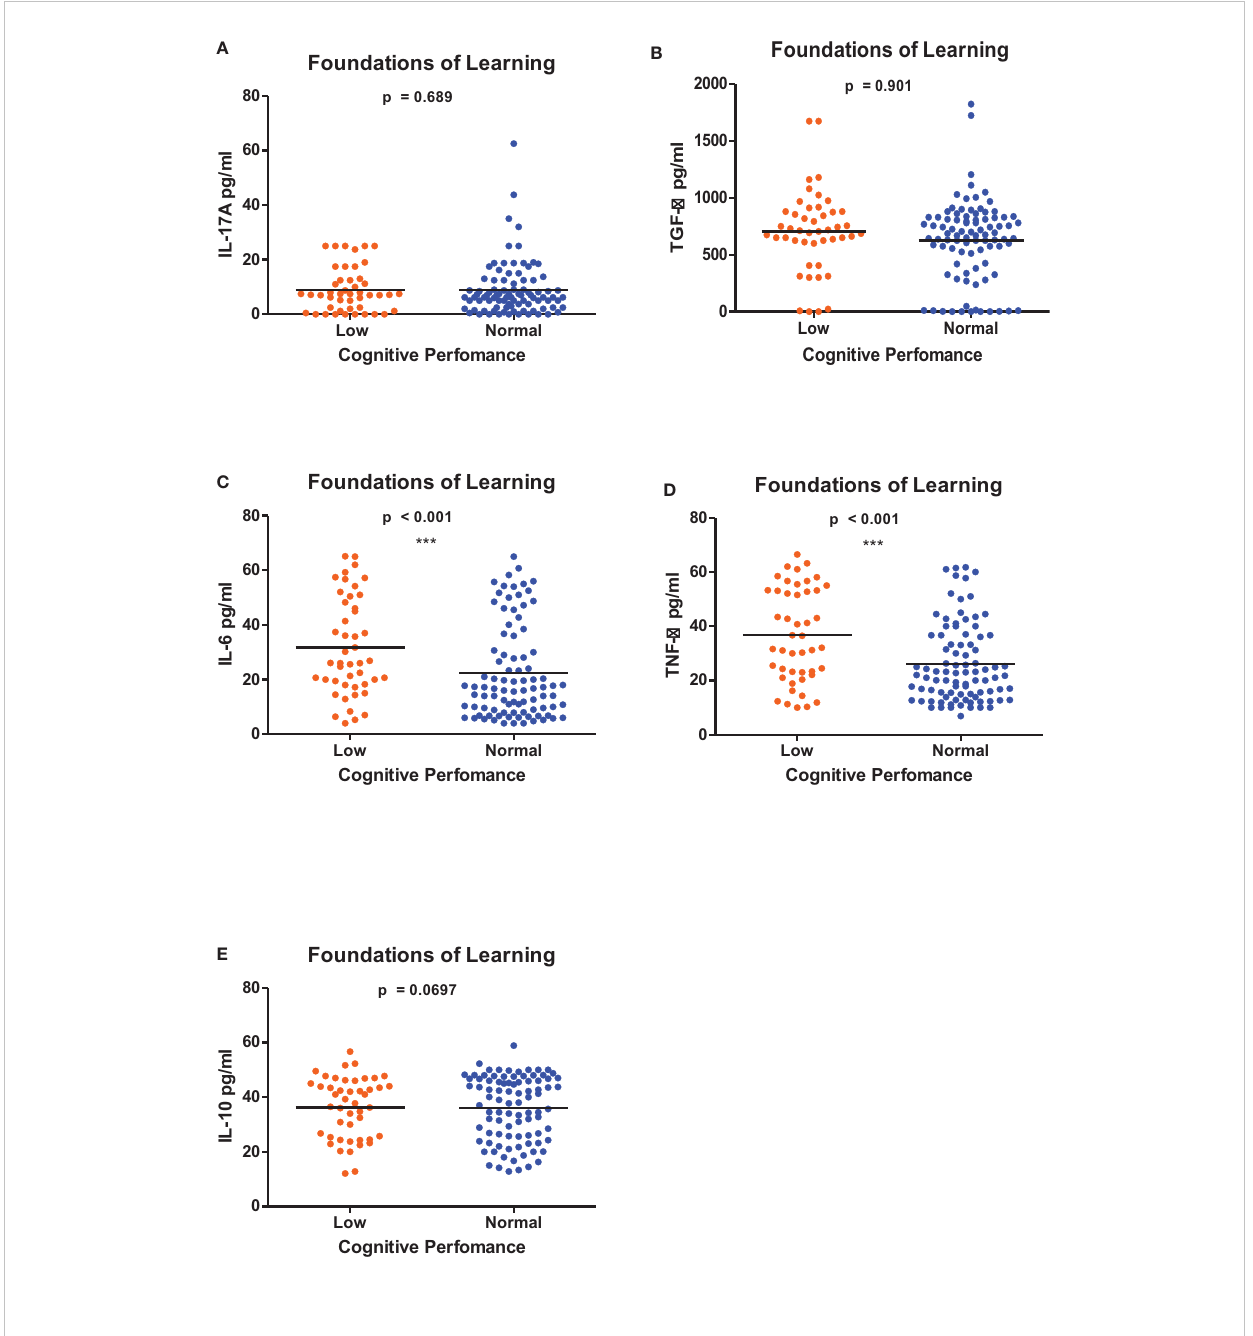
FIGURE 1 (A-E) Cytokine concentration level comparisons between low and normal PSAC performers in the Foundations for Learning Domain using the Wilcoxon matched-pairs signed rank test. ** = p ≤